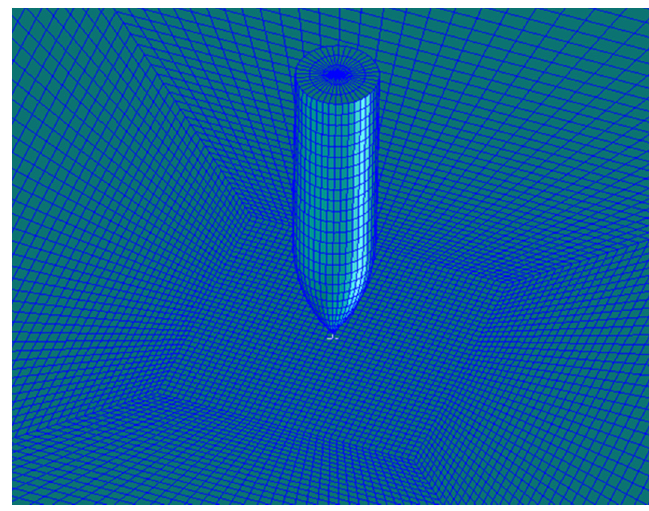
Figure 4. The numerical model of the projectile and solid plate.